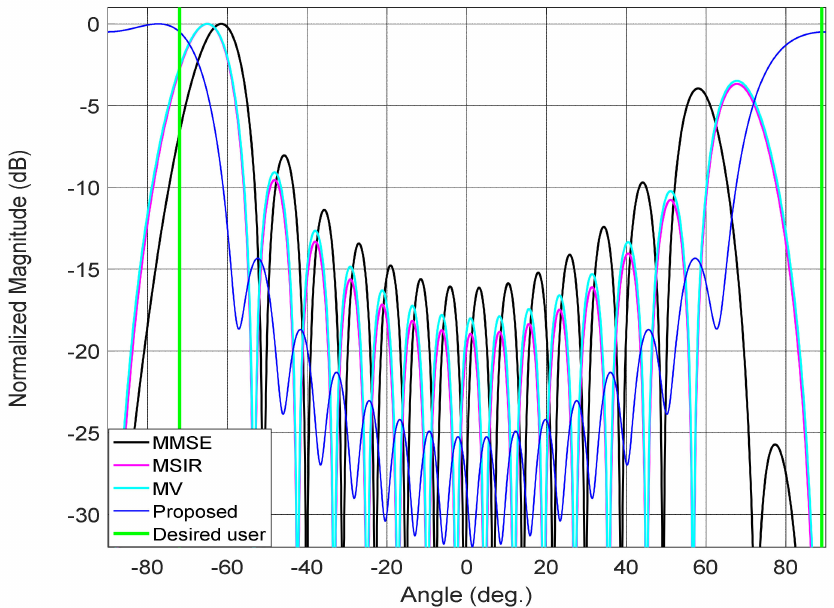
Figure 10. The performance comparison under the desired users’ directions scenario is located near the array